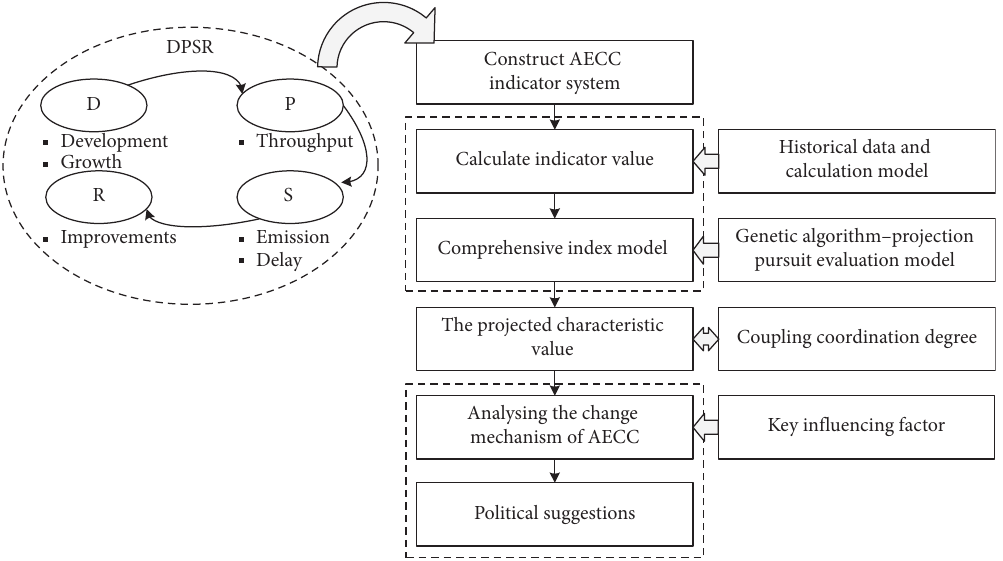
Figure 2: Evaluation framework of AECC.